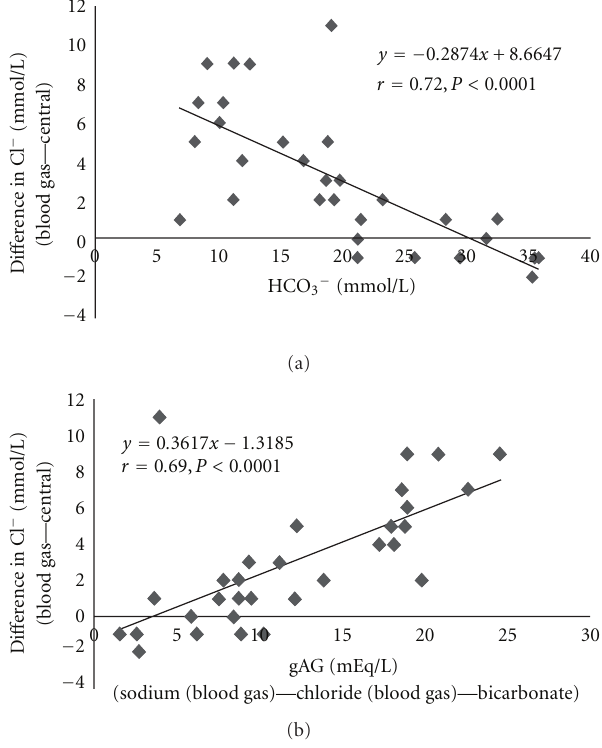
Figure 1: Correlations between the di ff erence in chloride (Cl − ) concentrations determined by two analyzers with bicarbonate (HCO 3 − ) concentrations (a) and gAG (b) in patients with severe acidemia (pH < 7 .